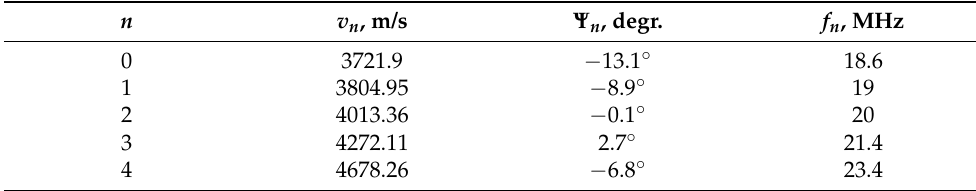
Figure 5. Insertion loss S 12 ( a ) and phase φ ( b ) measured for AIR (without liquid) and conductive liquids ( H 2 O + NaCl (5%)) with σ from 0 to 6 S/m deposited only between transducers (18 mm). Plate: 128°YX- LiNbO 3 , h = 500 μm. Mode f = 63.9 МГц, λ = 200 μm. Test liquid: distilled water H 2 O (200 mg) and distilled water (200 mg) with drops of 0.9% NaCl (40 mg) in the water (arrows). Table 2. Phase velocities v n , power flow angles Ψ n , and own frequencies f n for the first five modes in